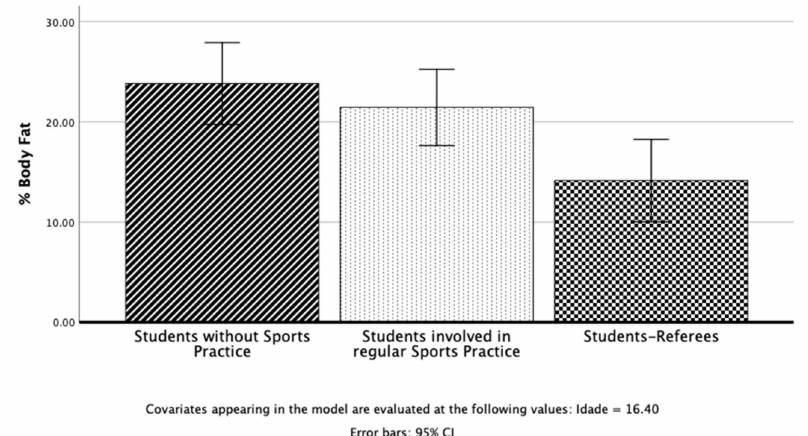
Figure 4. Students without sports practice, students involved in regular sports practice, and student referees in the